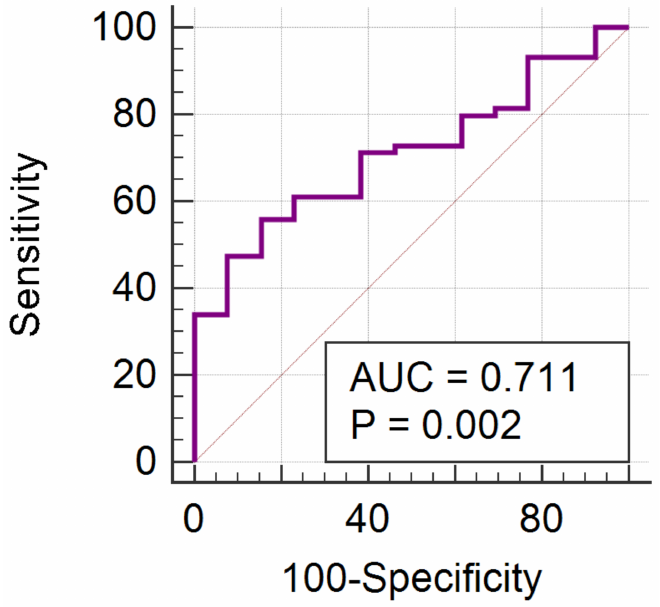
Figure 5. ROC curve of the RWavEnLH_s-4 in the diagnosis of ER+